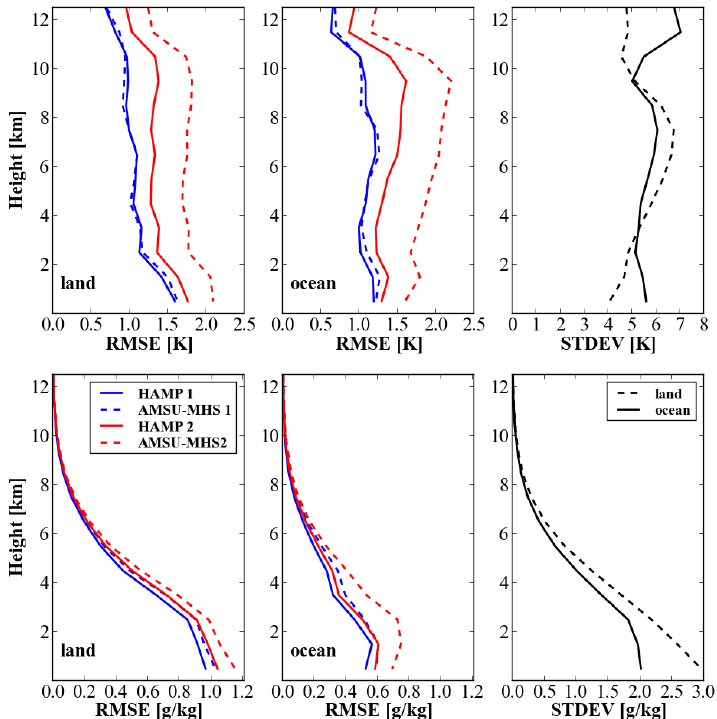
Figure 7. Retrieval RMSE over land (left), RMSE over ocean (middle), and test data set standard deviation (right) for temperature [K] (top panel) and water vapor mixing ratio [gkg − 1 ] (bottom panels) for the HAMP (solid line) and AMSU-MHS (dashed line) instruments with two different assumptions on T B uncertainty. See text for details.